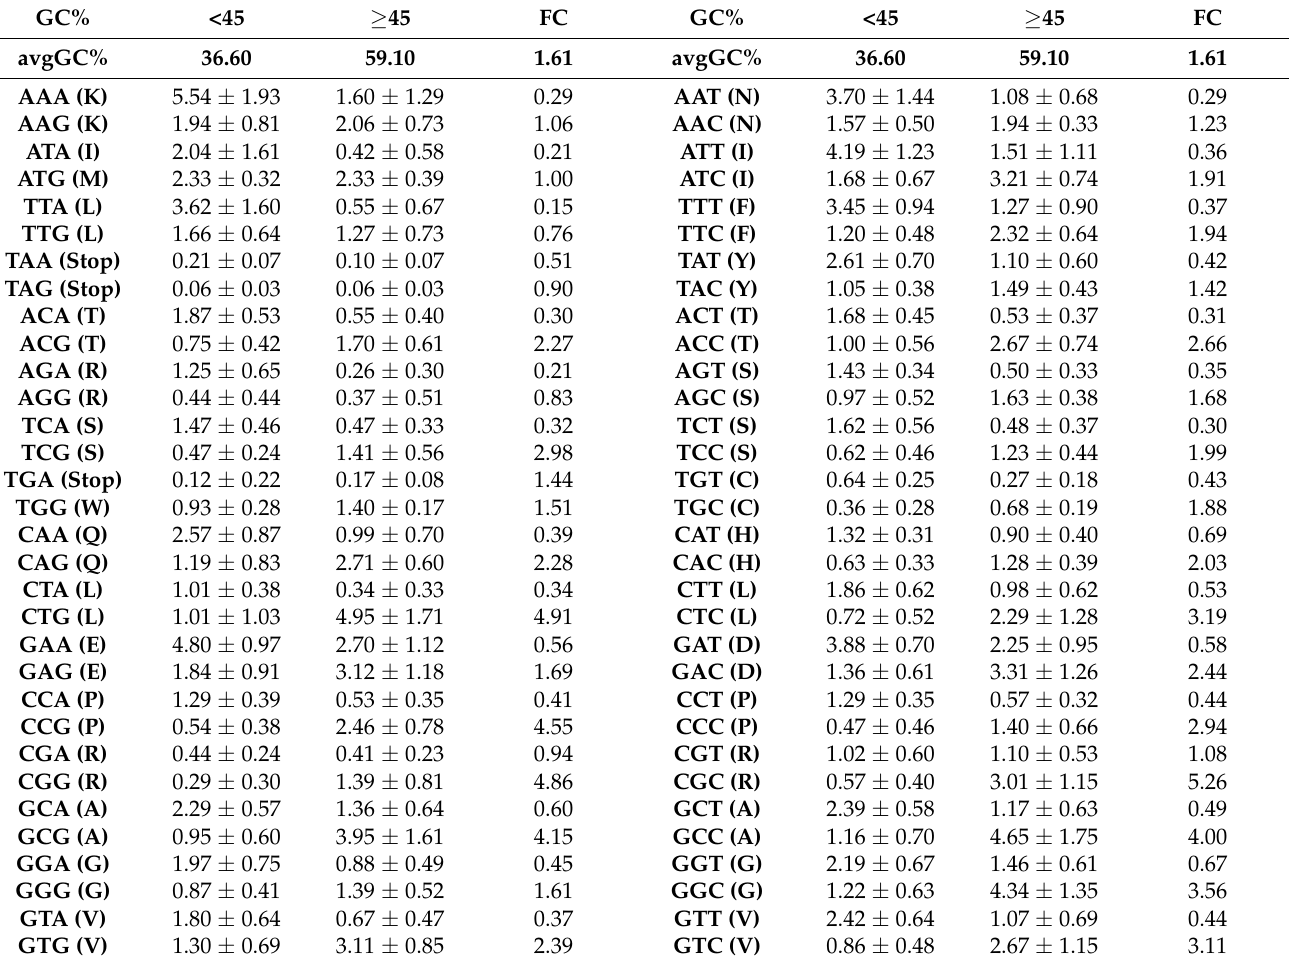
Table 1. Fold change of codon usage by species groups with different GC